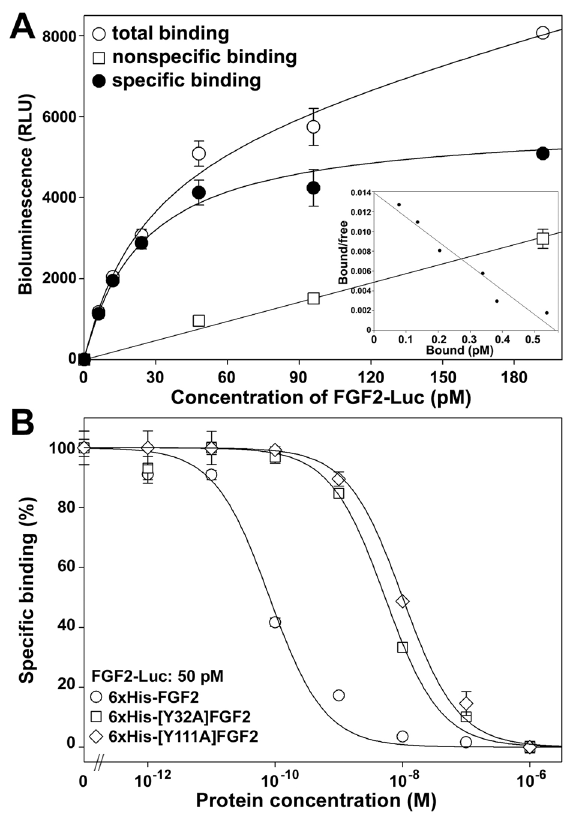
Fig 4. Binding of FGF2-Luc with the endogenous FGF receptor. Untransfected HEK293T cells were used as the receptor source. (A) Saturation binding of FGF2-Luc with the endogenous FGF receptor. Nonspecific binding data were obtained by competition with 250 nM of 6×His-FGF2. The measured bioluminescence data were expressed as mean ± SE ( n = 3). The total binding data were fitted to Y = B max X/(K d + X) + N s X, specific binding data to Y = B max X/(K d + X), and nonspecific binding data to a linear curve. Inner panel, Scatchard plot of the specific binding data. (B) Competition binding of wild-type or mutant FGF2s with the endogenous FGF receptor using FGF2-Luc as a tracer. The measured bioluminescence data were expressed as mean ± SE ( n = 3) and fitted with sigmoidal curves using the SigmaPlot10.0